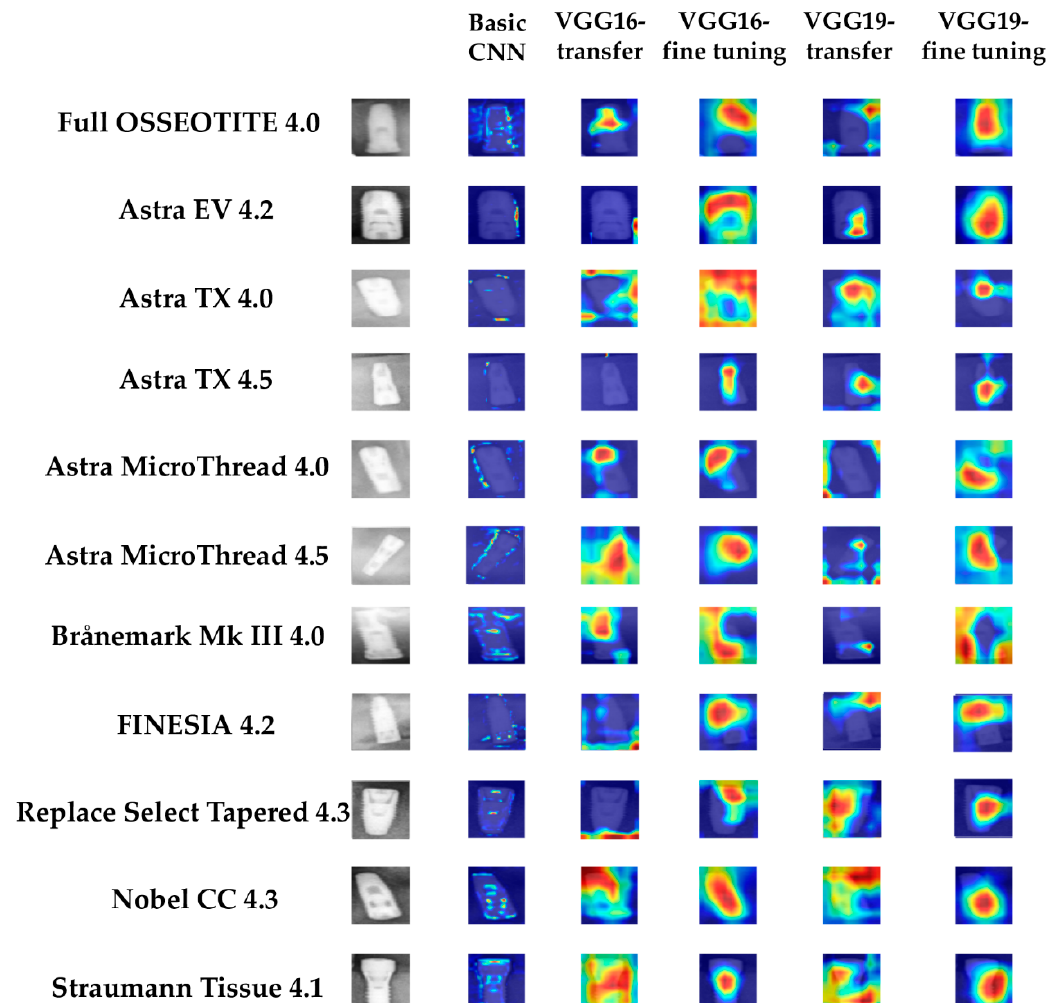
Figure 4. Example of the class activation maps of the five CNN networks for the eleven dental implant systems.